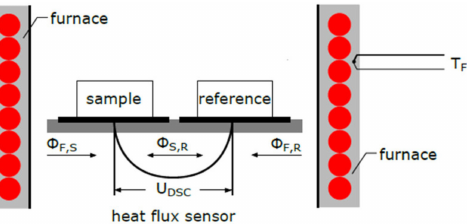
Figure 2. Schematics of a heat flow differential scanning calorimetry (DSC) with a disc-type sensor and illustrated heat flow